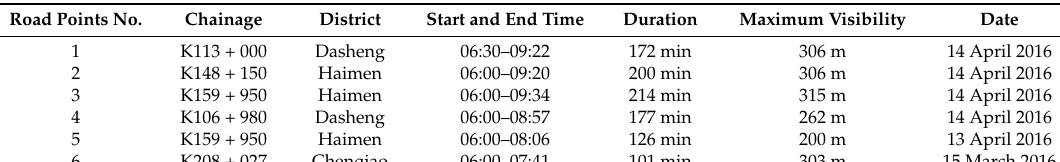
Table 1. Road points information.